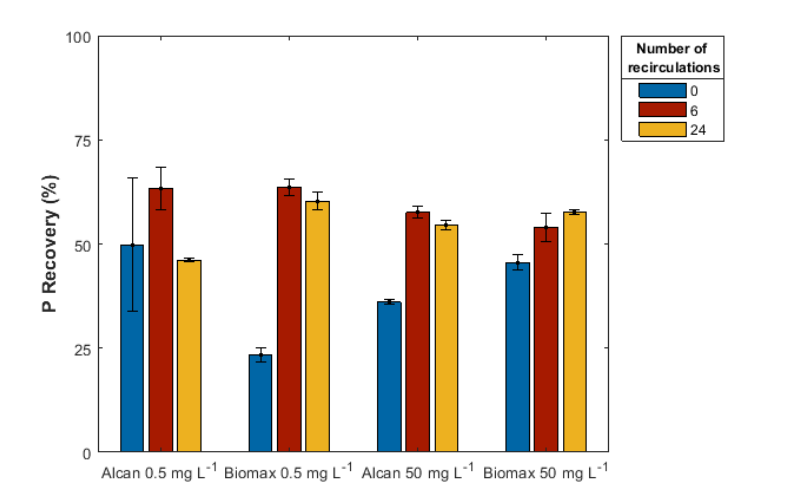
Figure 7. Effects of the number of recirculation of regenerative solution on phosphorus (P) recovery from P sorption materials (PSMs). Phosphorus recovery is shown after the first sorption-desorption cycle (S0-D0) only, treated with five pore volumes of 1 M KOH at a residence time of 0.5 min. Treatments separated based on PSM type and P concentration used during the sorption